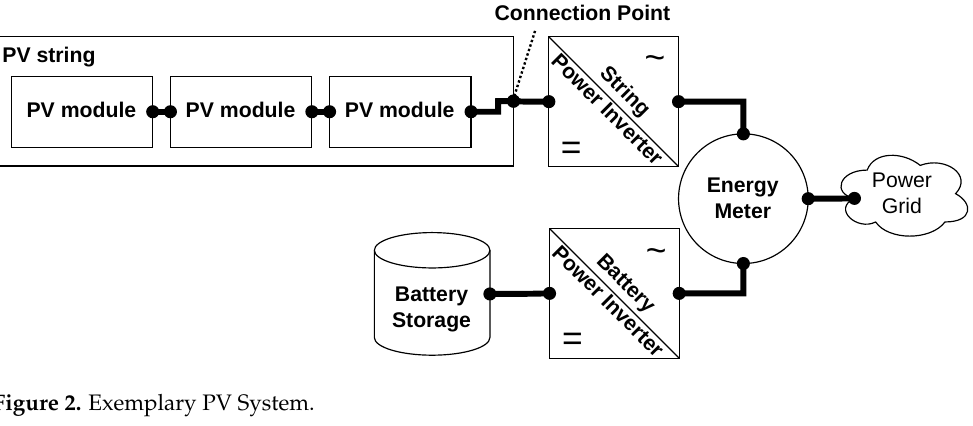
Figure 2. Exemplary PV